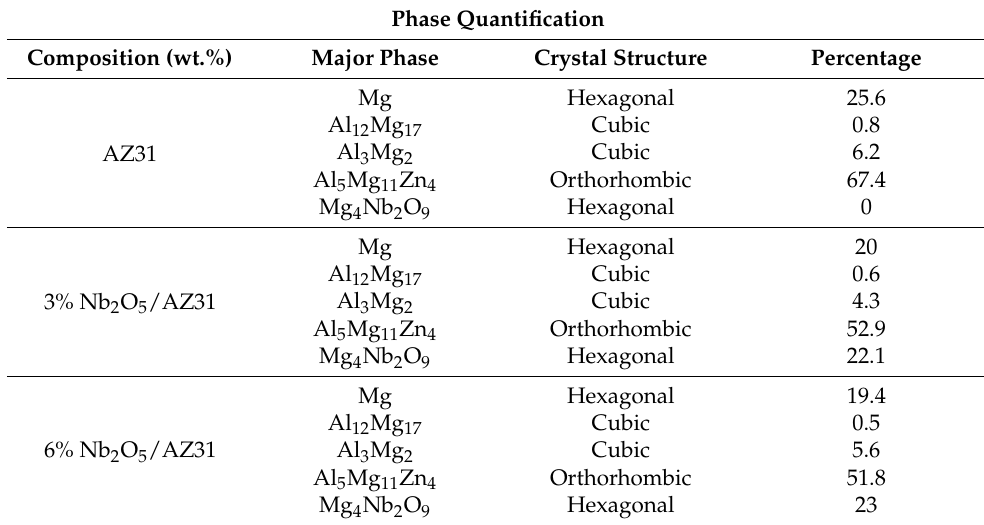
Table 2. Shows phase quantification and crystal